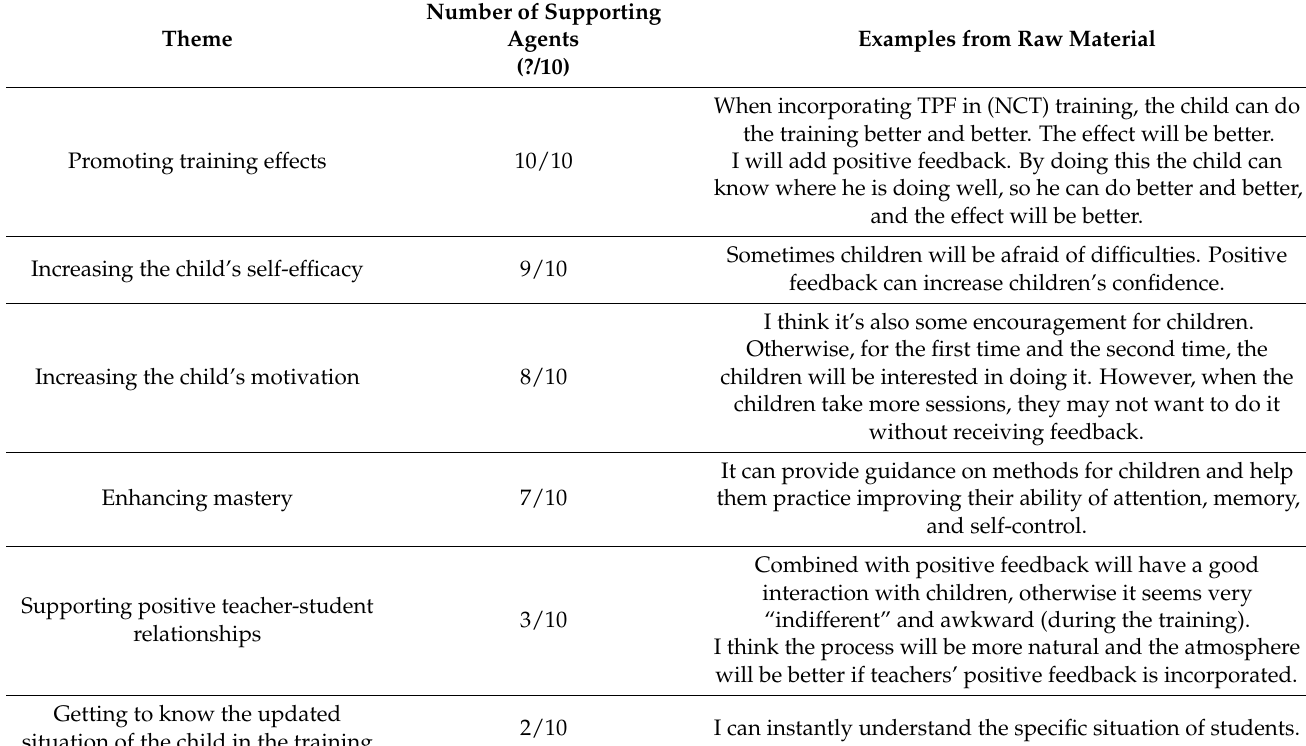
Table 3. Themes generated from the training agents’